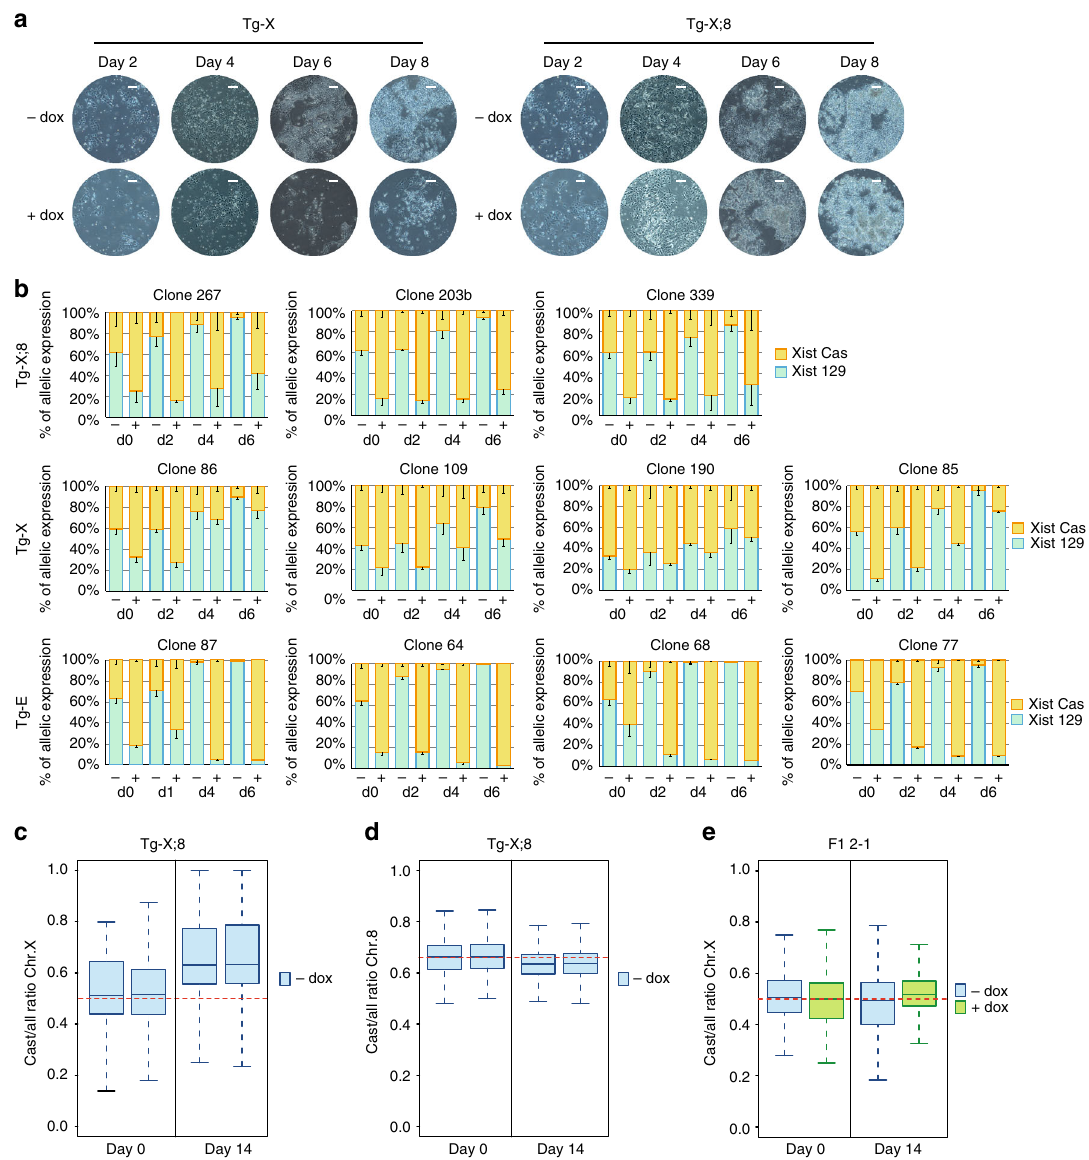
Fig. 4 Xist-mediated rescue of ESC clones from lethal aneuploidy. a Neuronal differentiation of Tg-X;8 and Tg-X clones. Representative bright fi eld images of live cells at day 2, 4, 6, and 8 of neuronal differentiation in doxycycline-treated and -untreated conditions are shown. Scale bars represent 100 μ m. b Xist allele-speci fi c qPCR analysis of Tg-X;8 ( top ), Tg-X ( middle ), and Tg-E ( bottom ) clones upon neuronal differentiation. Day 0 allele-speci fi c analysis refers to total Xist expression levels shown in Supplementary Fig. 5. The mean and SD of three to four independent experiments are shown. c , d RNA-seq analysis. Box plots showing Cast/all ratio of chromosomes X c and chromosome 8 d genes in Tg-X;8 clones at day 0 and day 14 of neuronal differentiation in the absence of doxycycline. Data of two independent experiments are shown. e RNA-seq analysis. Box plot showing Cast/all ratio of chromosome X genes at day 0 and 14 of neuronal differentiation of wild-type F1 2-1